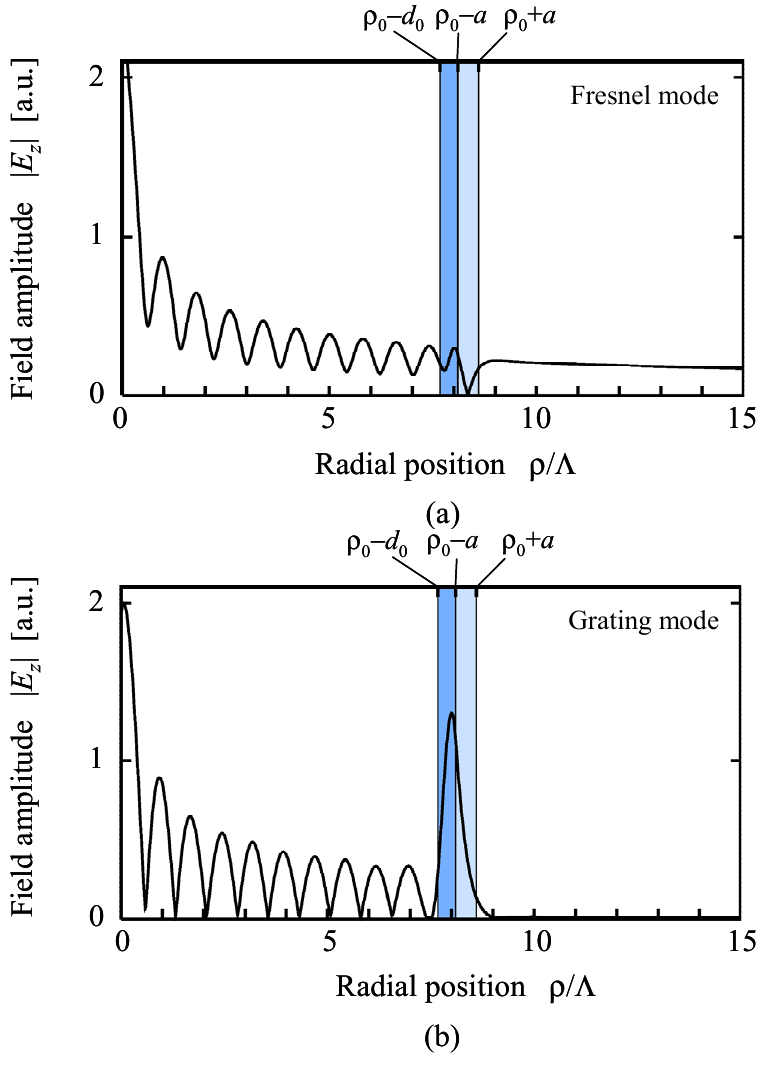
Figure 9. ( a ) Electric field distribution of a Fresnel mode, indicated by “F” in Figure 7(a); ( b ) High-Q grating mode, indicated by “G” in Figure 7(a) and Figure 8. The size of the cavity is m = 52.47 (virtual